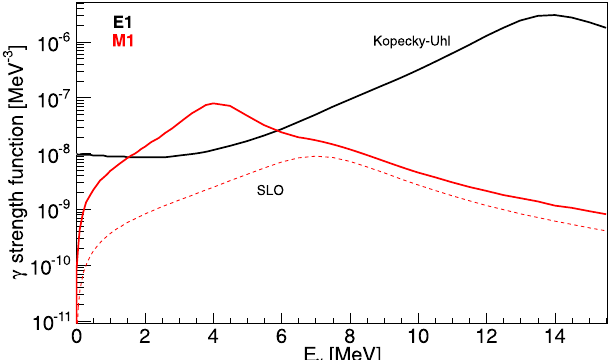
Fig. 9. E1 and M1 strength function of 177 Lu. The full black line shows the so-called Kopecky and Uhl [33] model implemented in TALYS for the E1 strength. The dashed red line corresponds to the default model for the M1 strength, namely the standard Lorentzian model [27,28]. The full red line shows the M1 strength obtained introducing a supplementary component in the M1 strength with a second Lorentzian centered around 4